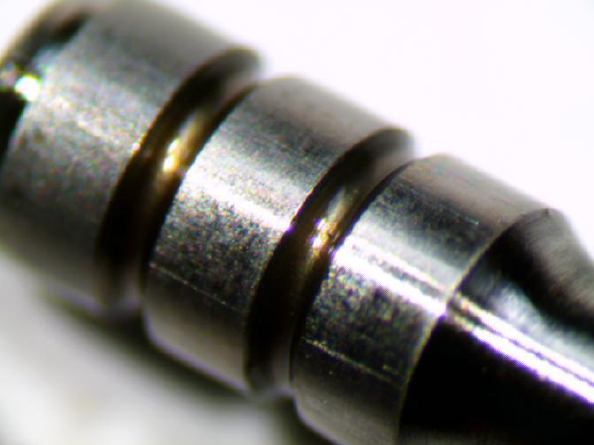
Fig. 5. Friction wear on the guide surface of the control